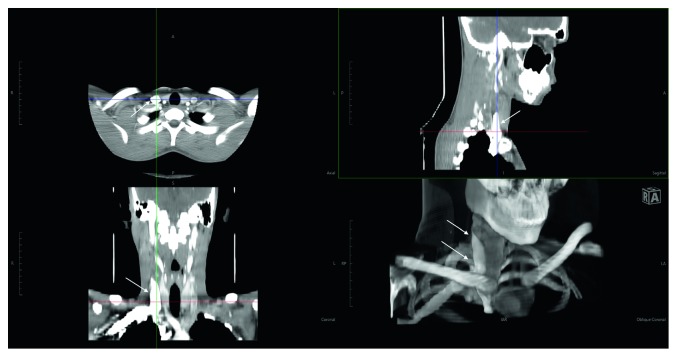
Neck mass (arrows).